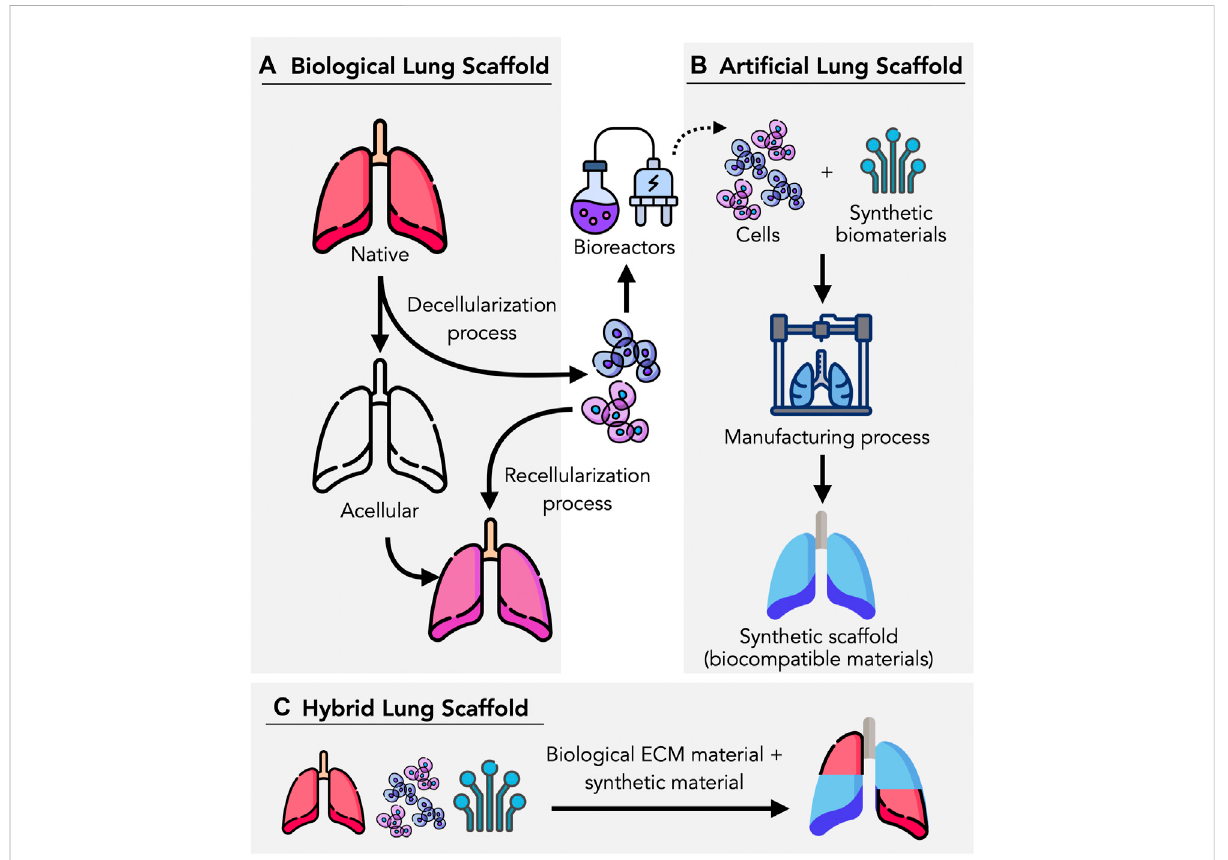
FIGURE 1 Lung tissue scaffolds can be bioengineering in different ways. (A) Biological lung scaffolds can be obtained from humans and animals, where they are decellularized using enzymatic agents and detergents to remove cellular components and achieve an ECM-based, acellular scaffold. (B) Arti fi cial scaffolds can be manufactured based on a variety of methods (e.g., 3D bioprinting, electrospinning), utilizing synthetic biomaterials, cells, and bioinks. (C) By combining biological components such as cells and ECMs, hybrid scaffolds can be manufactured in combination with biocompatible materials which provide the necessary structure and mechanical proprieties to promote cell proliferation, adhesion and viability. Figure designed by Freepik with elements from fl